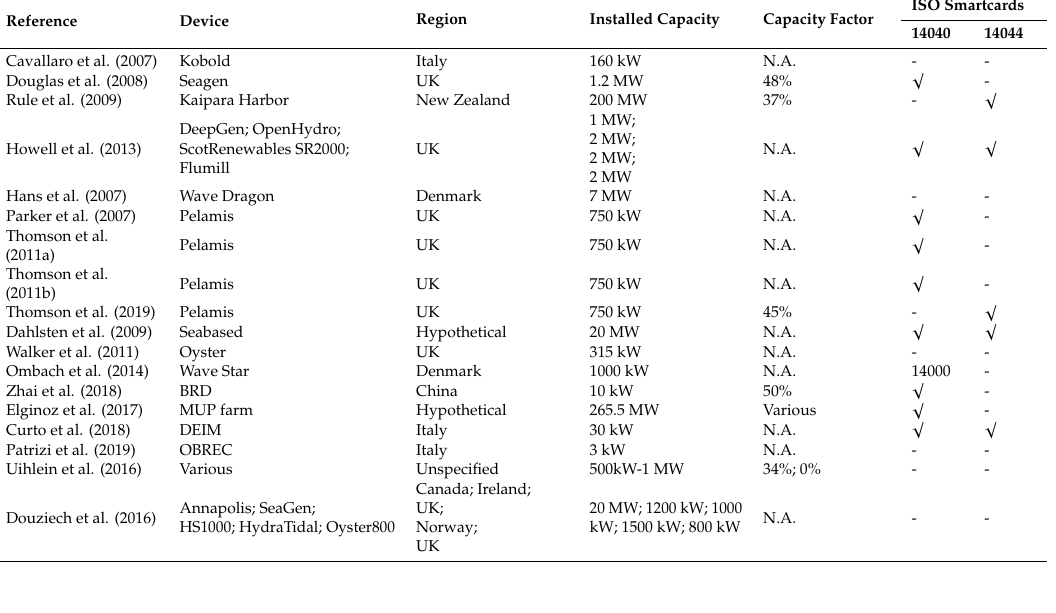
Table 1. General info of the studied wave and tidal systems studied by life cycle assessments (LCAs).